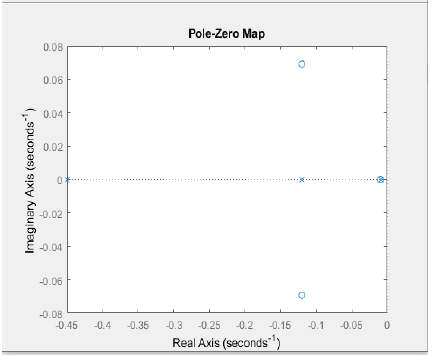
Figure 27. Plot of poles and zeros of n = 5, state variables.